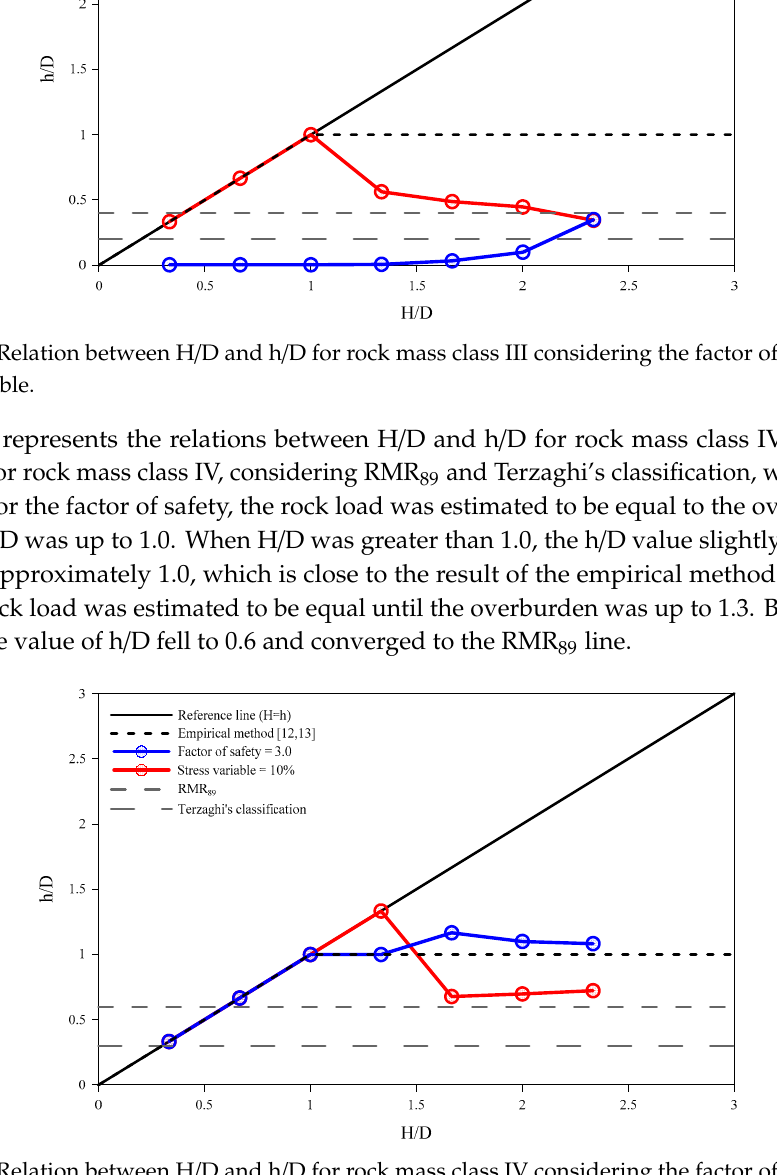
Figure 11. Relation between H/D and h/D from the stress variable method.